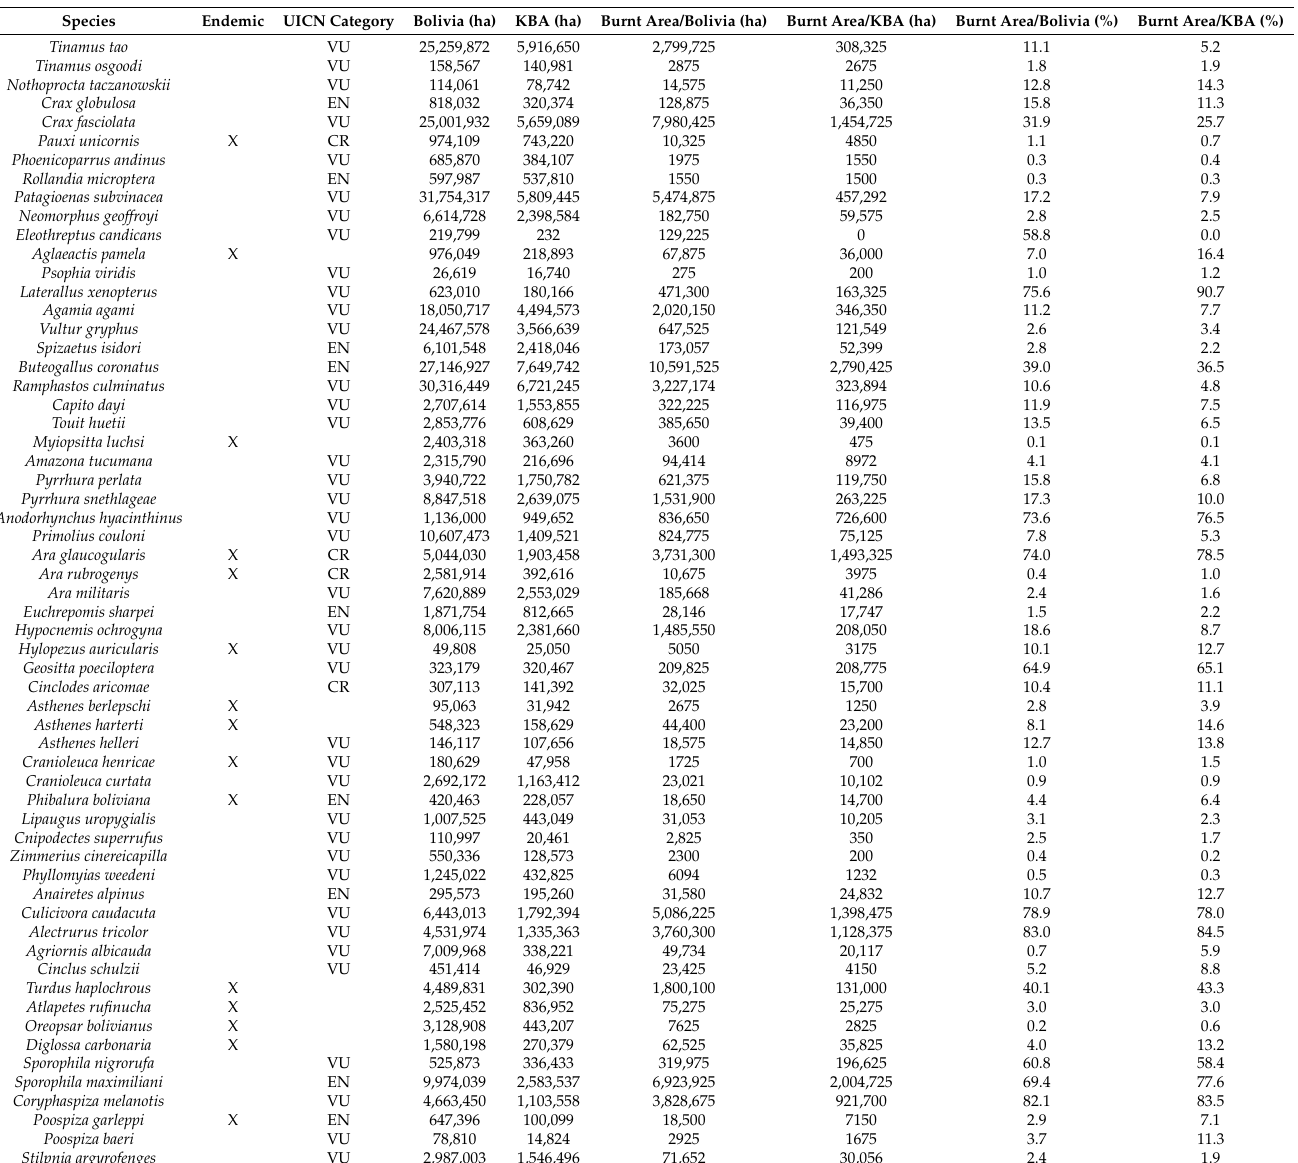
Table A2. Impact of fires on endemic and threatened bird species in Bolivia and the KBAs. CR = Critically Endangered, EN = Endangered, VU =